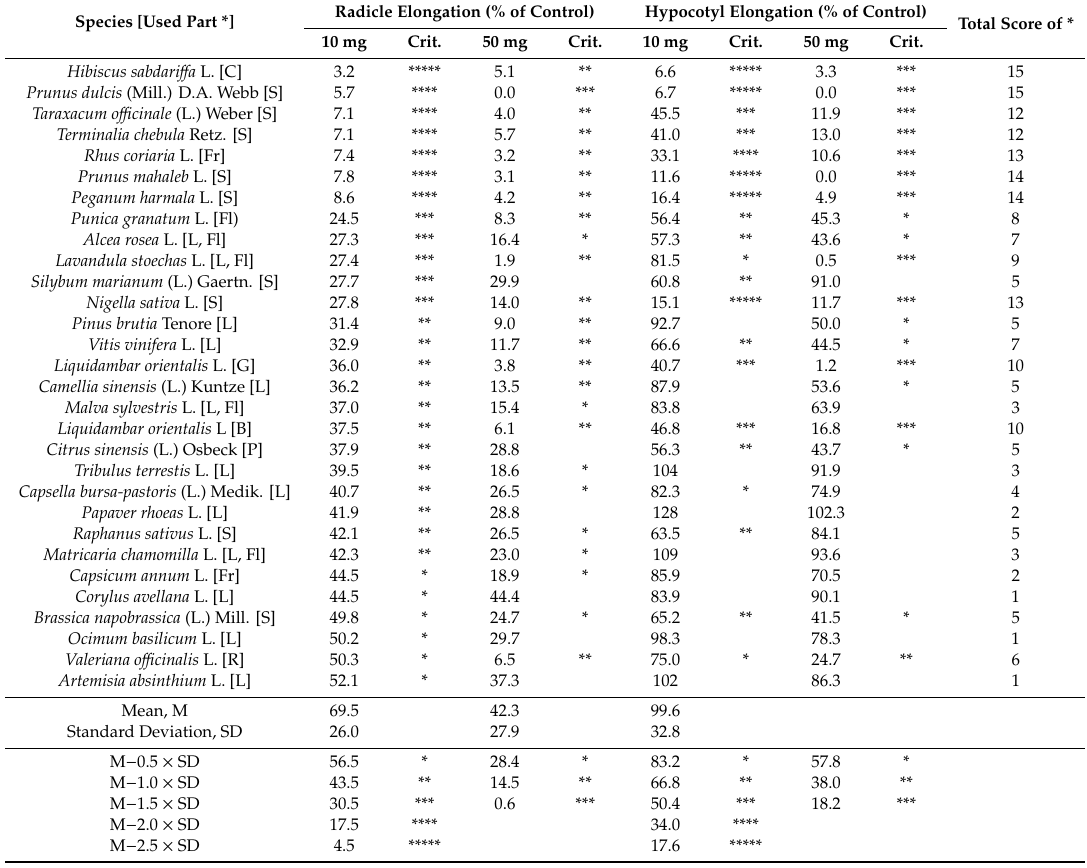
Table 1. The radicle and hypocotyl elongation percentages of lettuce seedlings grown on agar gel containing plant materials tested by sandwich method. Overview of top 30 most inhibitory plants. Species [Used Part *] Radicle Elongation (% of Control) Hypocotyl Elongation (% of Control) Total Score of * 10 mg Crit. 50 mg Crit. 10 mg Crit. 50 mg Crit.